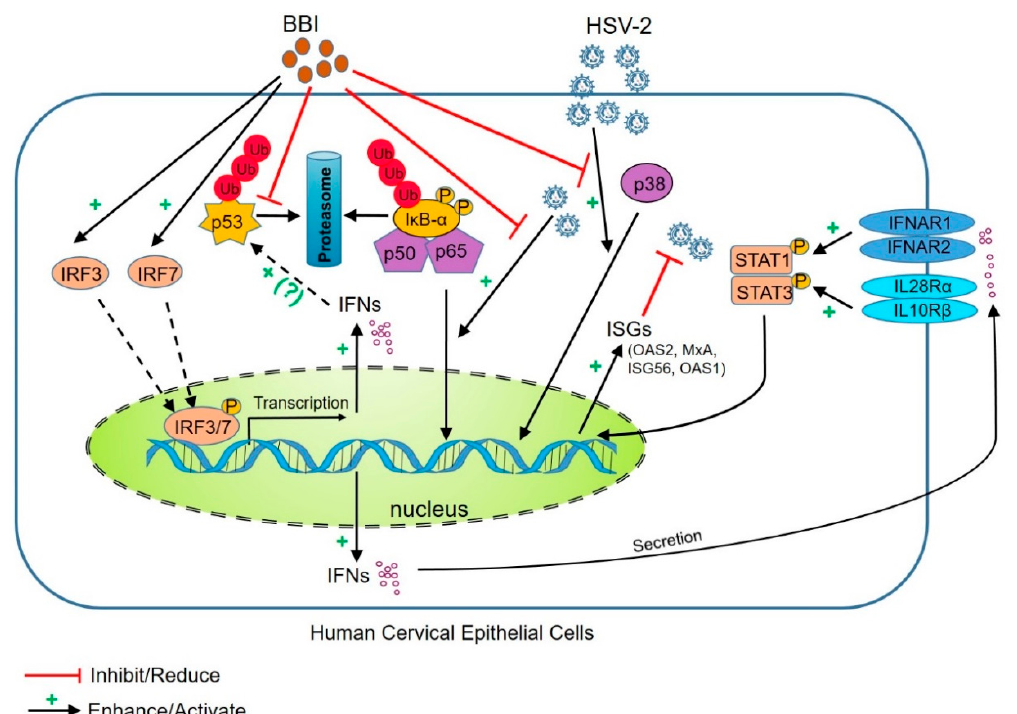
Figure 8. Hypothetical model of the anti-HSV-2 mechanisms of BBI. BBI inhibits HSV-2 infection through the following mechanisms: First, BBI induces IFN-based innate immune activation, resulting in the induction of the antiviral ISGs (OAS2, MxA, ISG56, OAS1) that inhibit HSV-2 replication; Second, BBI inhibits the UPS-mediated degradation of ubiquitinated proteins and p53; Third, BBI inhibits HSV-2-induced NF- κ B and p38 MAPK activation.